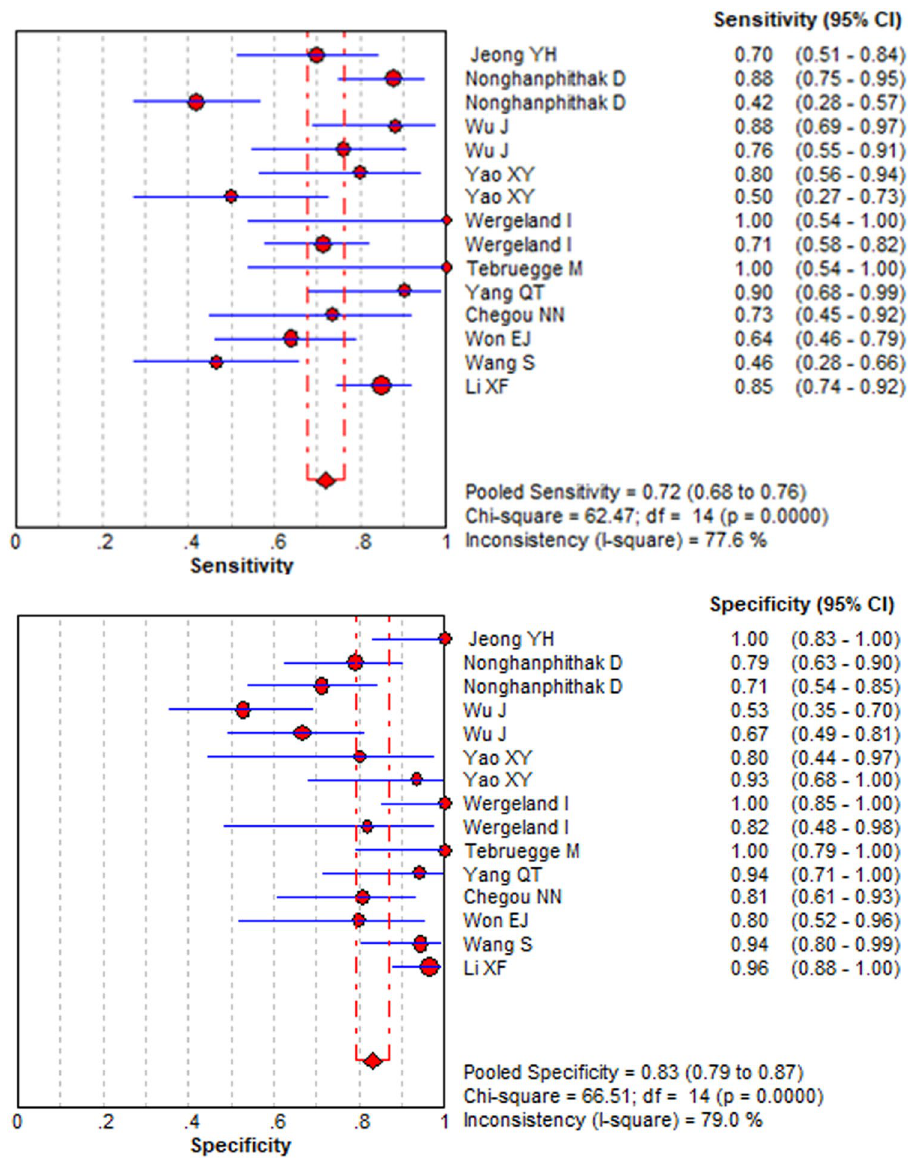
Figure 2. The forest plots of the pooled sensitivity and specificity of IP-10 for differentiating ATB from LTBI. The sensitivity ranged from 0.46 to 1.00 (pooled sensitivity: 0.72, 95% CI: 0.68–0.76, I 2 = 77.6%); whereas, the specificity ranged from 0.53 to 1.00 (pooled specificity: 0.83, 95% CI: 0.79–0.87, I 2 =